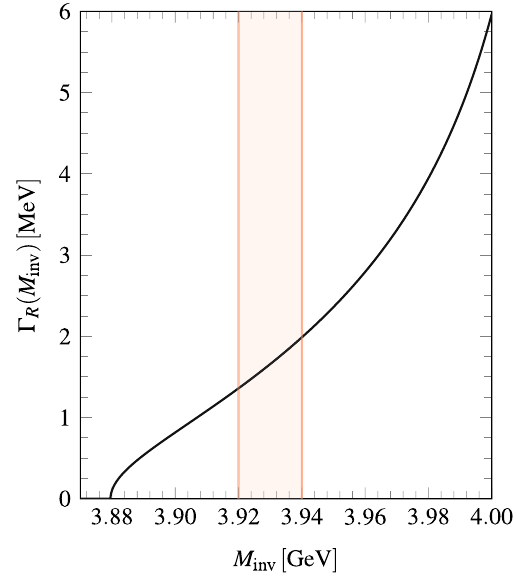
Fig. 10 Contribution to the width (cid:4) X as a function of the J /ψω invariant mass. The vertical lines delimit the region of the